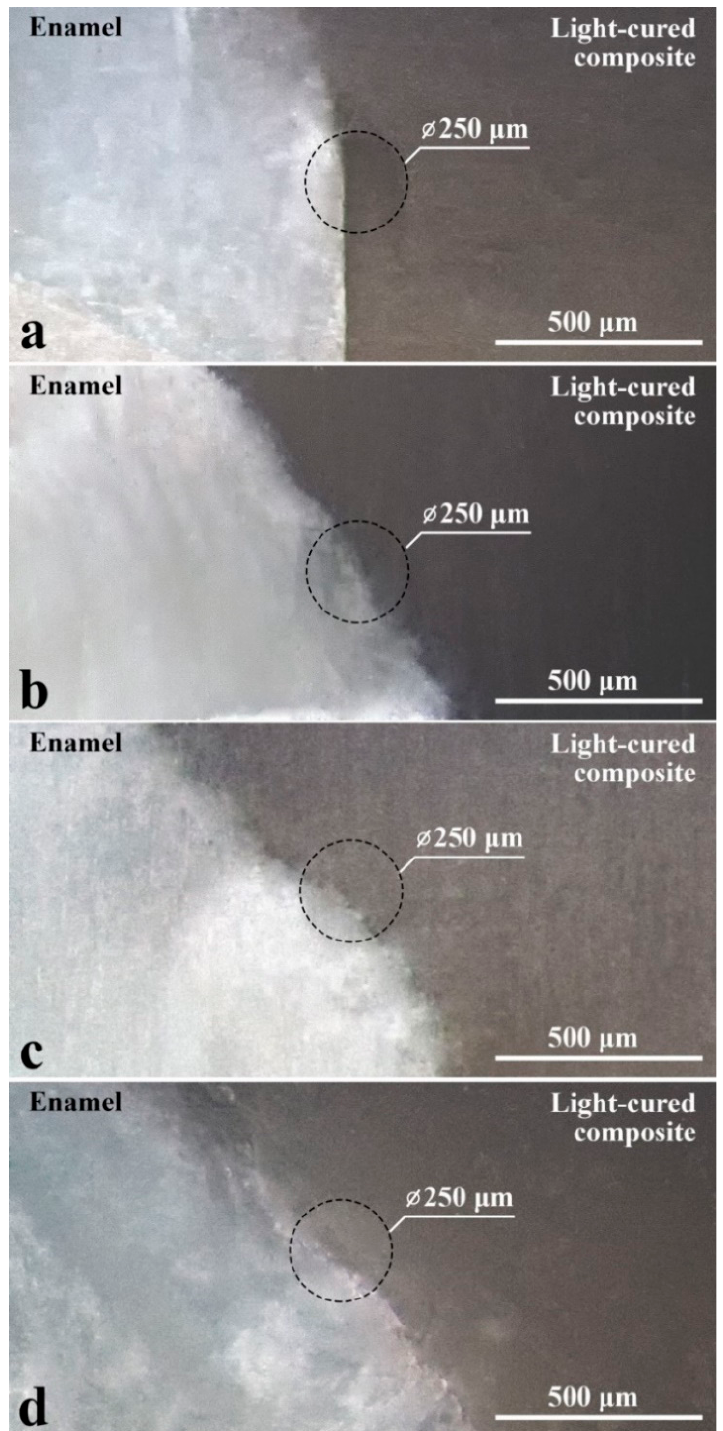
Figure 1. Optical images of the heterointerface sections of natural enamel-dental composite for the studied samples. ( a ) Sample S I ; ( b ) Sample S II ; ( c ) Sample S III ; ( d ) Sample S IV .